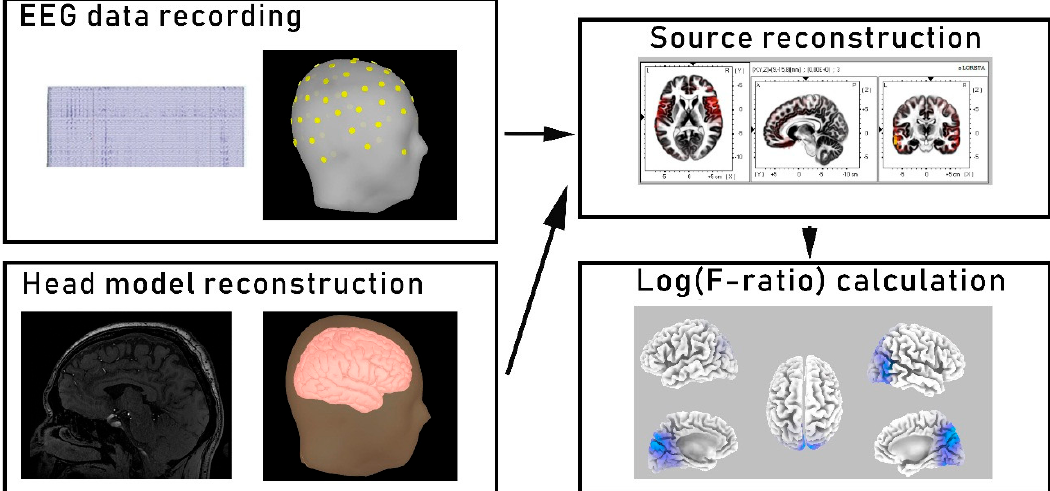
Figure 1. Source reconstruction analysis flowchart. In the first step, the electroencephalogram (EEG) signals were recorded, filtered, and segmented. Second, the head model was reconstructed using the MNI152 scalp template. Third, sources were reconstructed by applying the low-resolution brain electromagnetic tomography (eLORETA) algorithm for every participant and in every frequency band. Finally, the differences in source localization (in each frequency band) between the two groups were evaluated using voxel-by-voxel independent sample F-ratio tests.